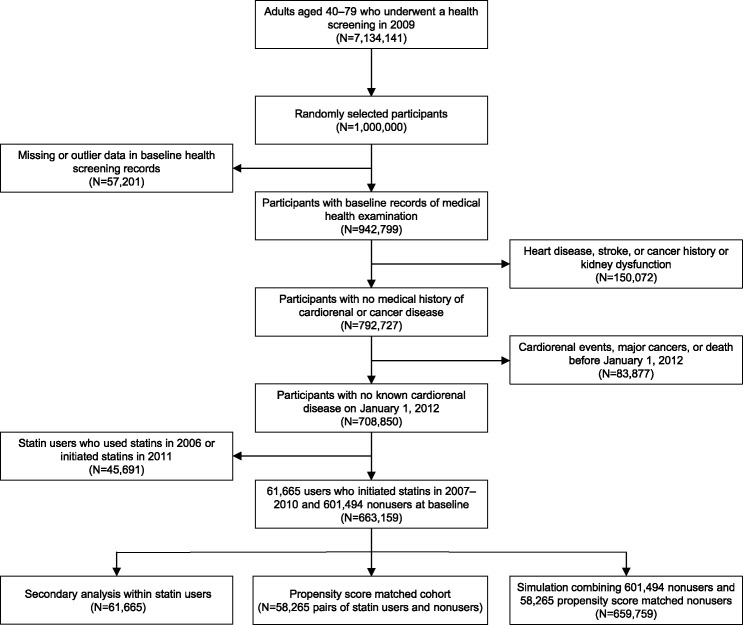
Flow chart of participant selection.